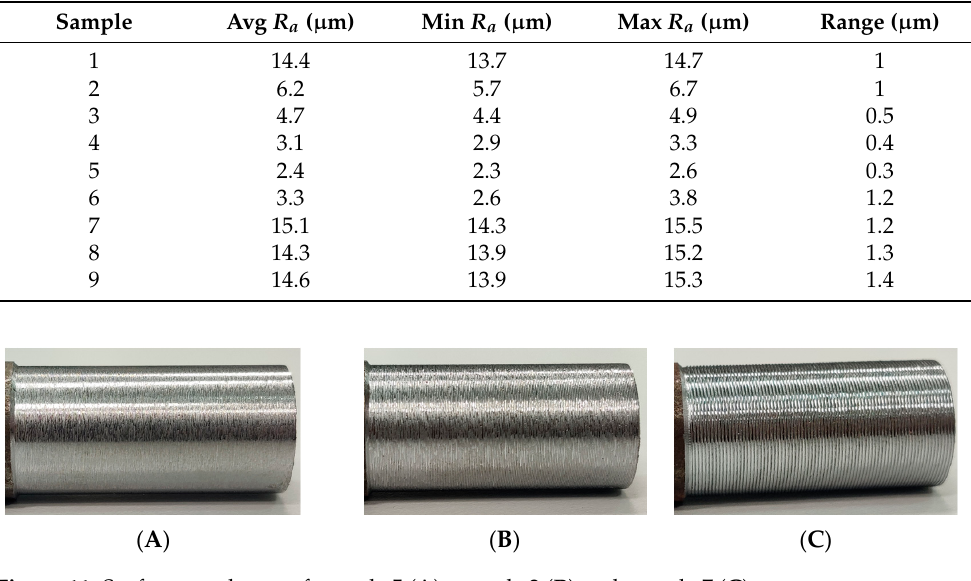
Figure 11. Surface roughness of sample 5 ( A ), sample 2 ( B ) and sample 7 ( C ).